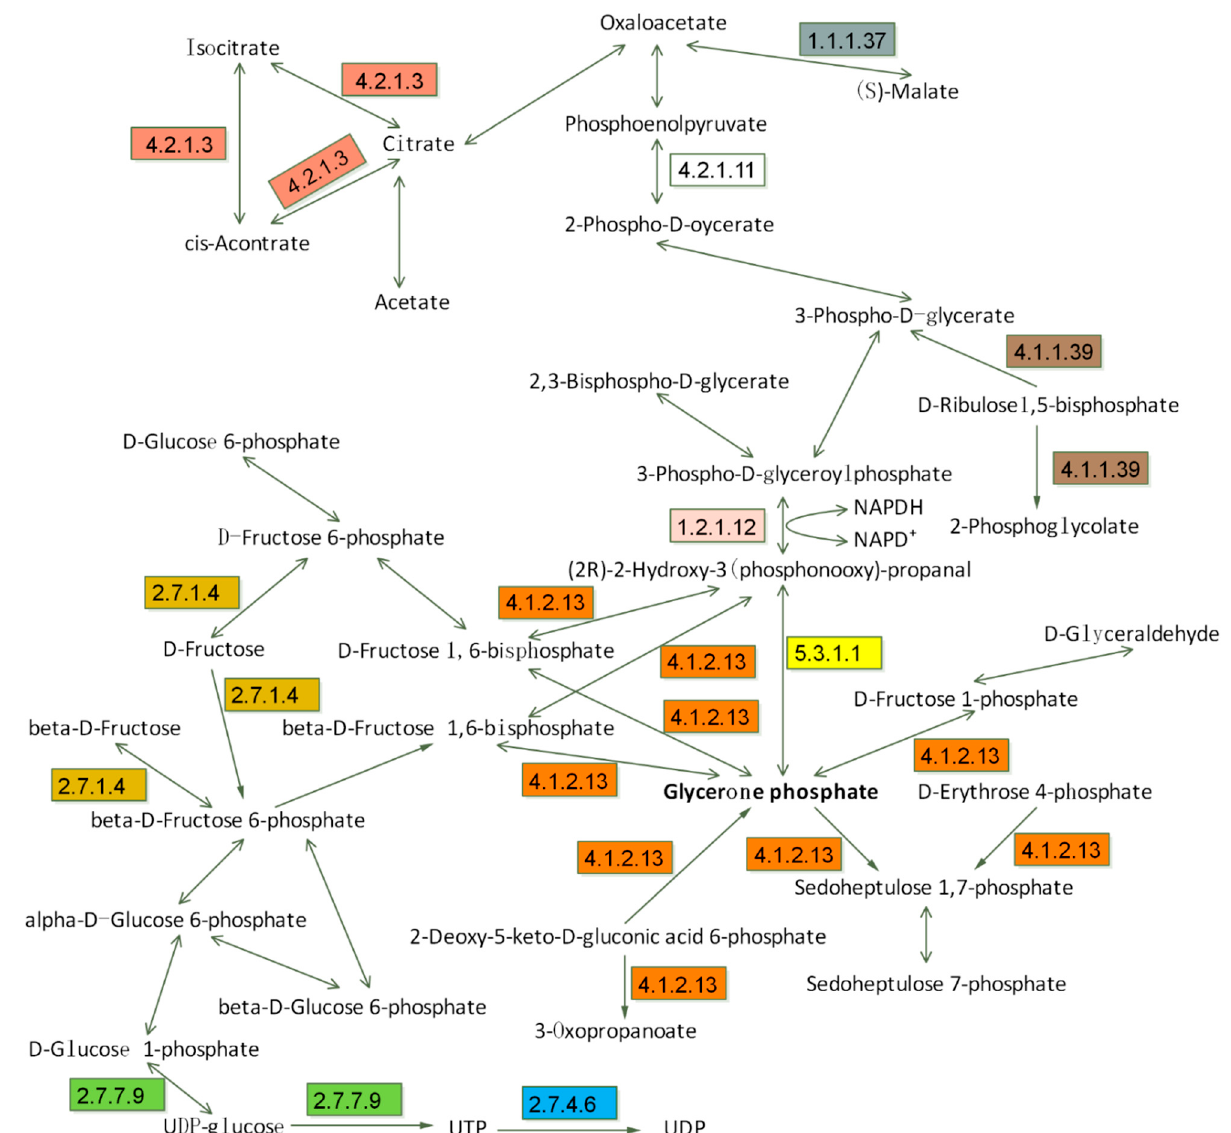
Figure 4. Carbohydrate and energy metabolisms of differential enzymes referred in the KEGG pathway database. Boxes with different colors are different enzyme numbers.